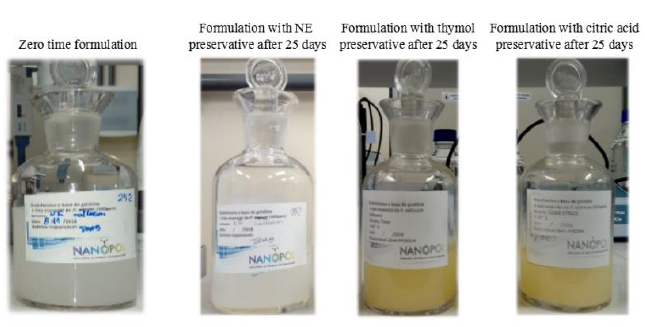
Figure 2: organoleptic properties, the